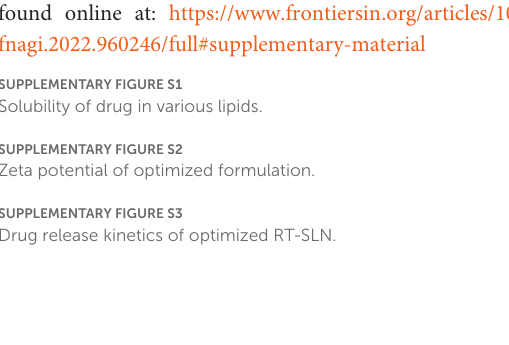
SUPPLEMENTARYFIGURES3 Drug release kinetics of optimized